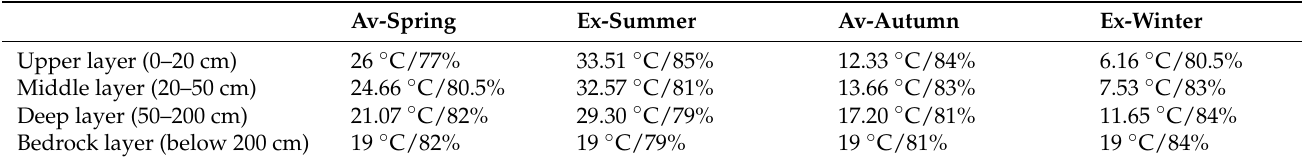
Table 3. Soil temperature and relative soil humidity of each soil layer in ENVI-met.